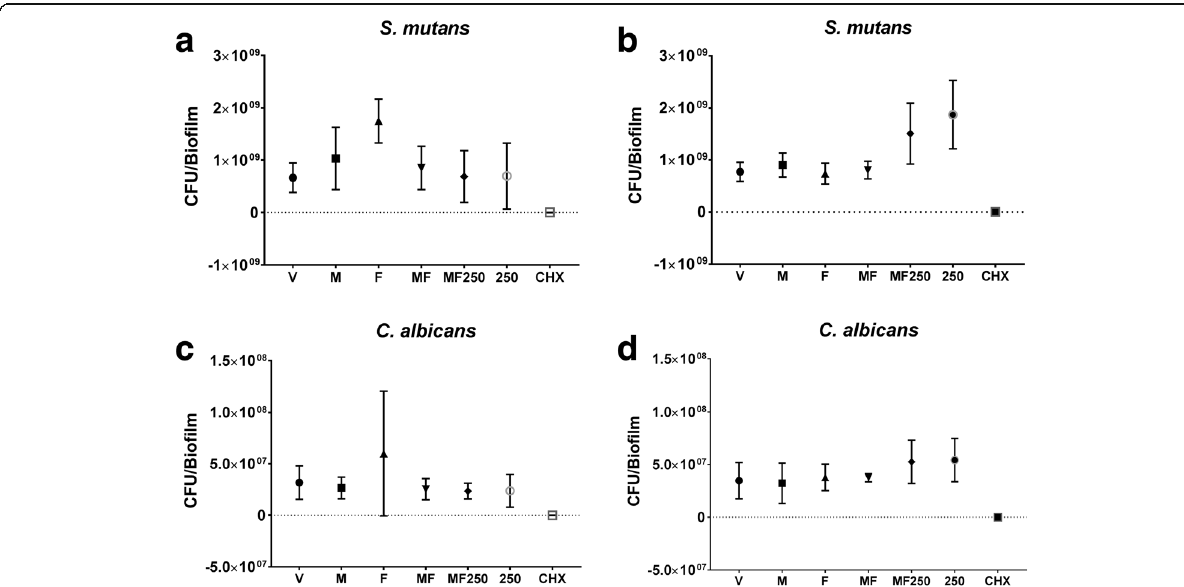
Fig. 4 Microbial population of S. mutans and C. albicans after treatment of biofilms. Data are presented as colony forming unit (CFU) per biofilm. a and c represent data generated for regimen one, while ( b ) and ( d ) correspond to regimen two. V: vehicle; F: tt- farnesol; M: myricetin; MF: tt -farnesol bars indicate the standard deviation